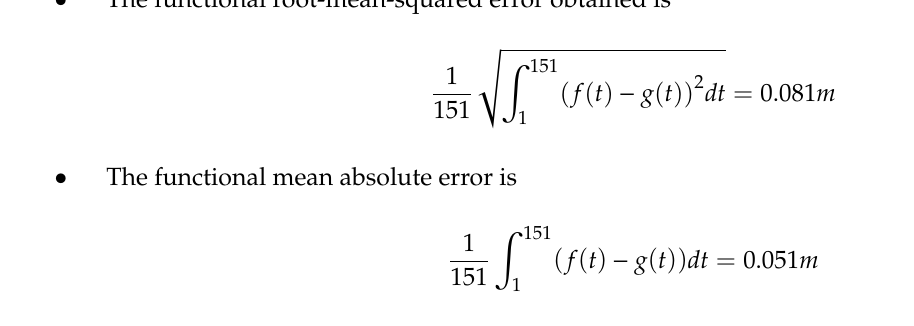
Table 1. Numerical values for each distance to the origin of the profile of Figure 10, expressed in terms of the difference (m) between the predictive data and those obtained in the field for the year 2018.